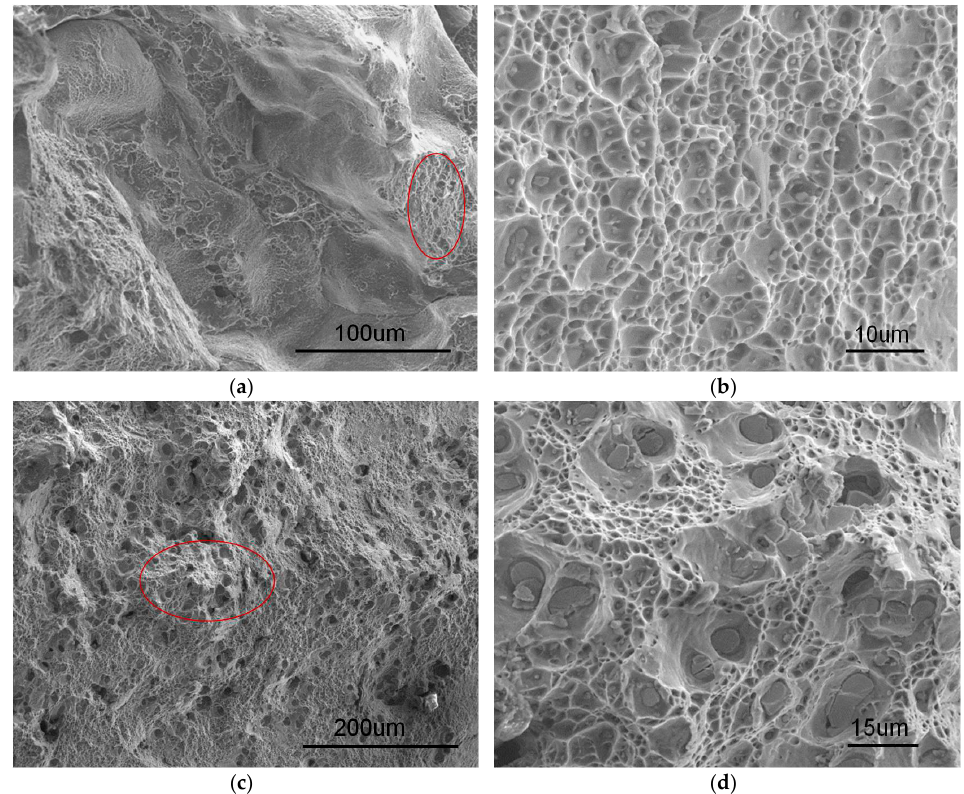
Figure 10. Tensile fracture morphology of 2219 aluminum alloys with different Cu contents: ( a , b ) 5.56Cu; ( c , d ) 6.52Cu.